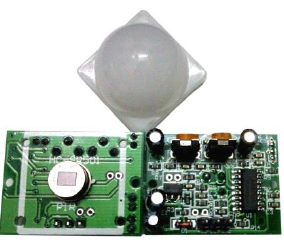
Figure 6. HC-SR501 human infrared sensor module physical map.